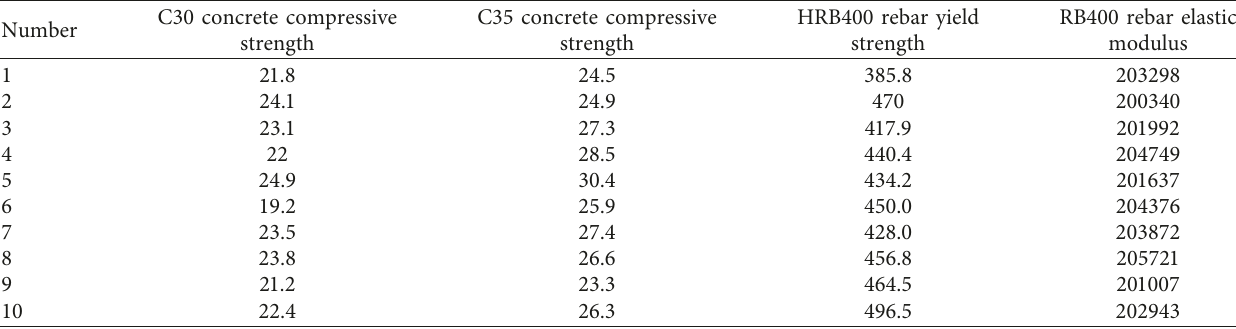
Table 4: Latin hypercube sampling parameters (N/mm 2 ).